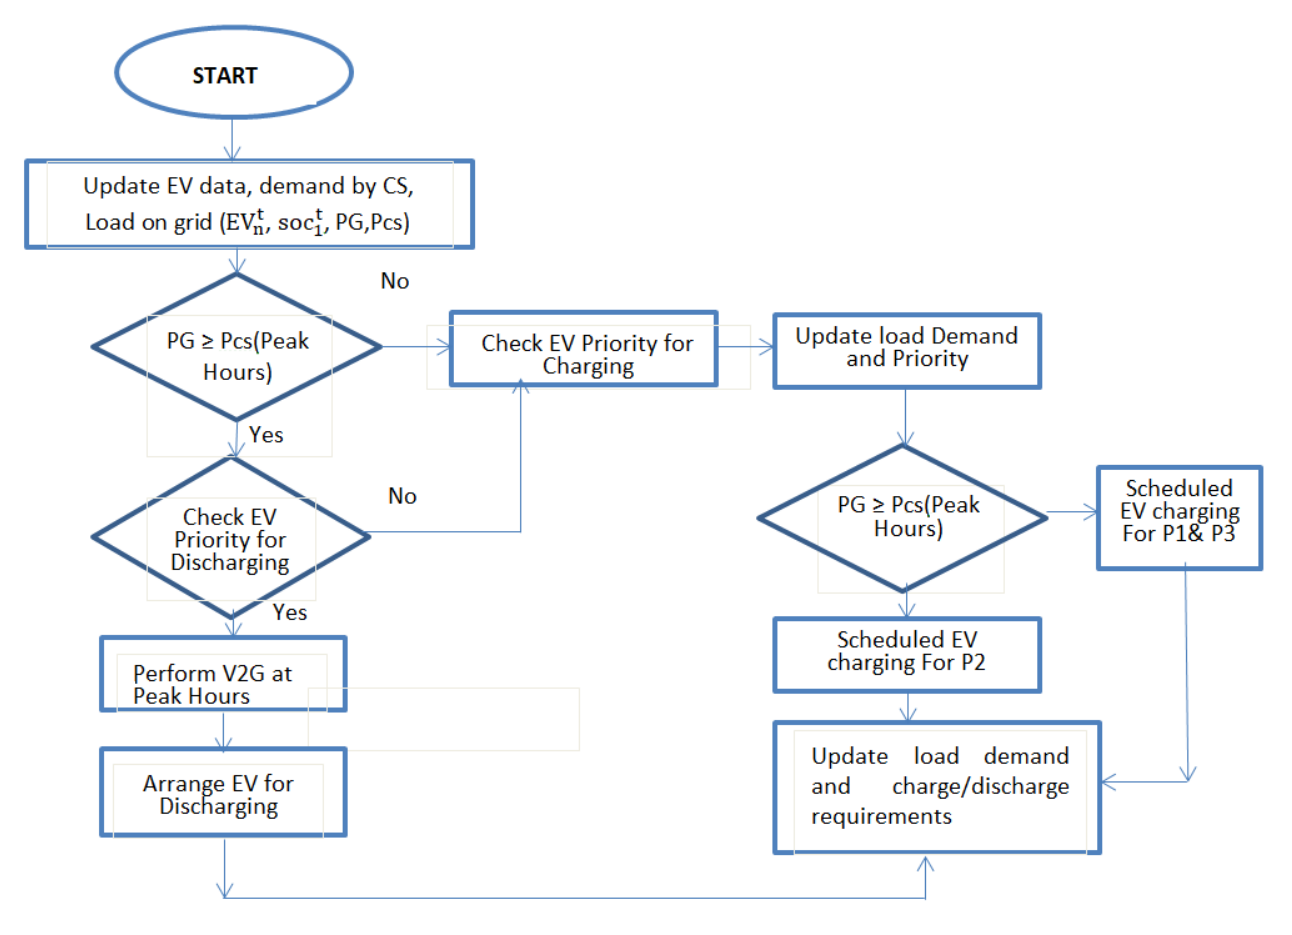
Figure 2. EV user priority ‐ based flow chart.